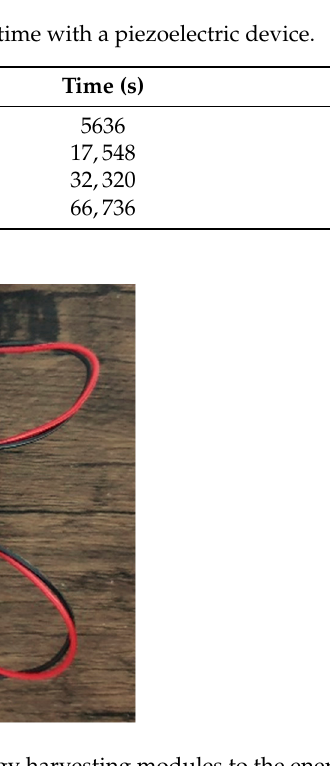
Table 2. 10 F Super capacitor charging time with a piezoelectric device.